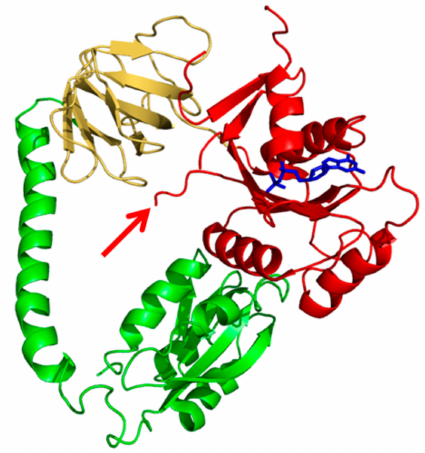
Figure 1. 3D structure of of Thermus thermophilus IF2 bound to GDP (blue). The IF2 domains are colour-coded: G2 (red), G3 (yellow) and C1 (green). The red arrow indicates the position of His301 at the tip of switch II. The figure is from pdb file